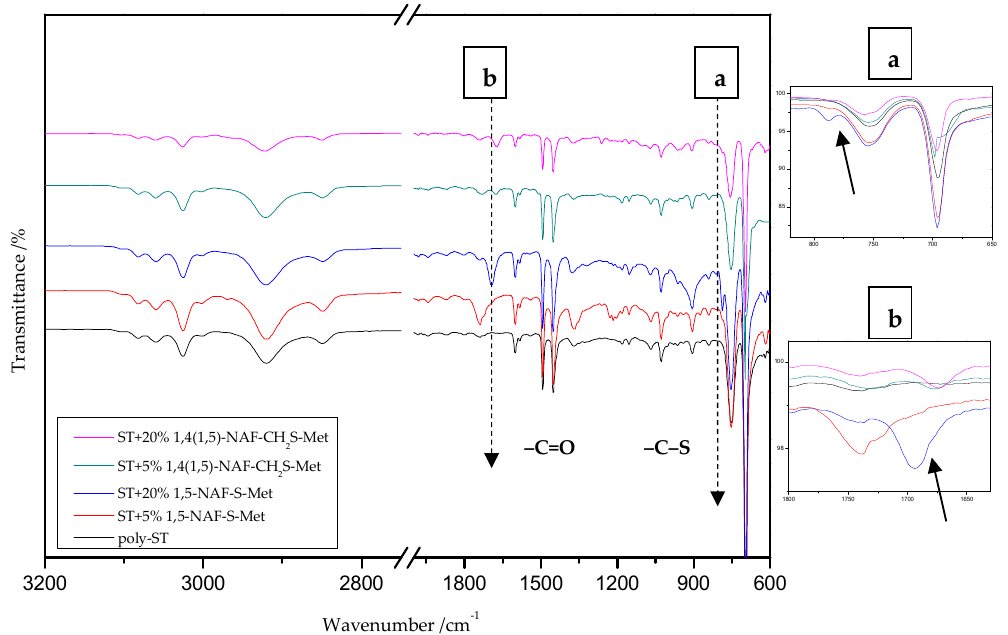
Figure 4. The ATR/FTIR spectra of poly-styrene (ST) and its copolymers with 5% and 20% addition of 1,5-NAF-S-Met and 1,4(1,5)-NAF-CH 2 S-Met.